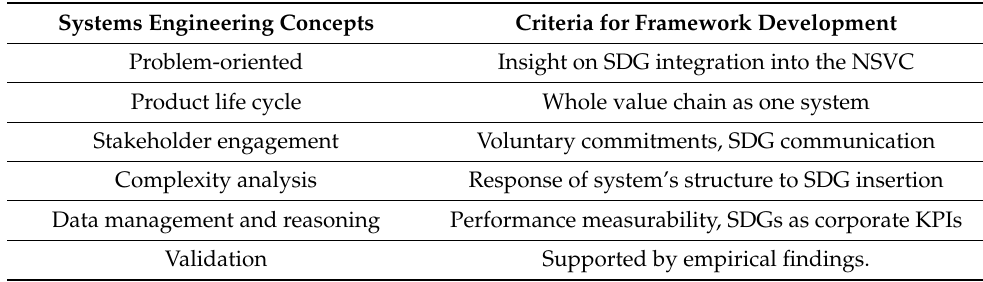
Table 2. SE concepts [23,57] as required criteria in the developed